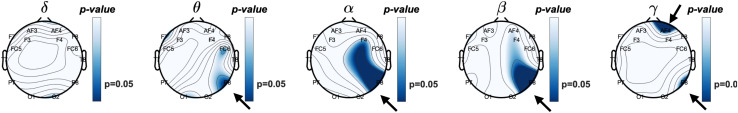
Topographical plot of Pearson correlations between relative frequency band power of resting eyes-closed EEG and Accuracy (% correct) of the working memory task.